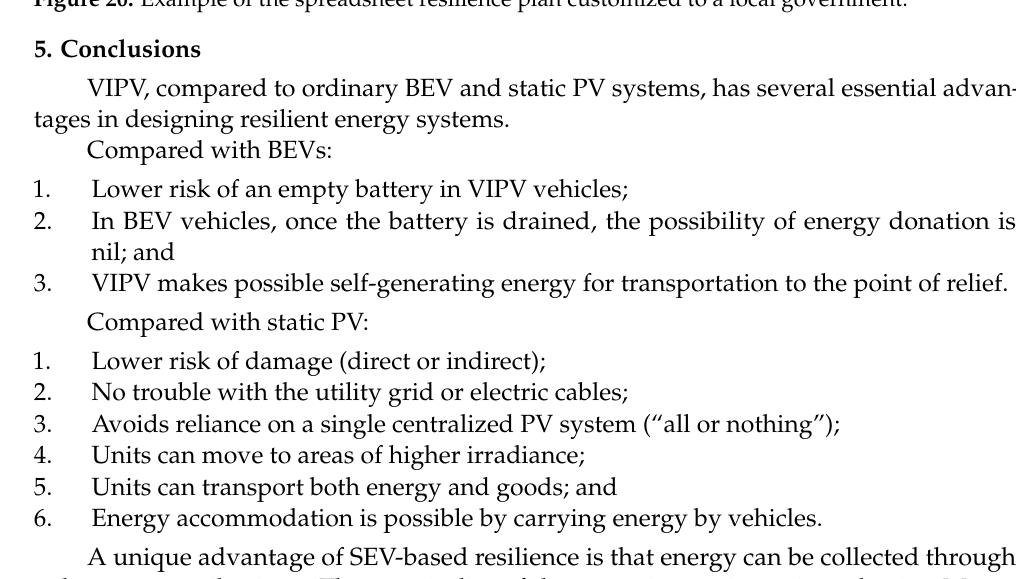
Figure 20. Example of the spreadsheet resilience plan customized to a local government.